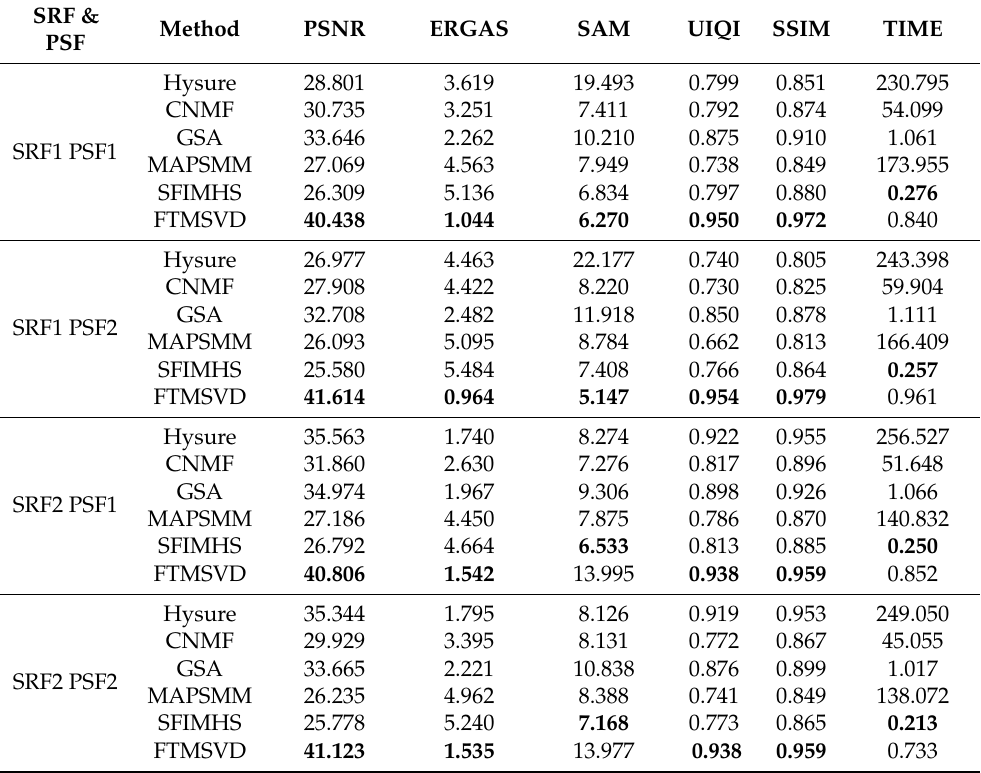
Table 6. Average quantitative results of the blind methods on the CAVE data set.